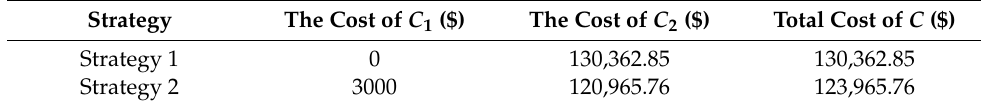
Table 1. Cost analysis under different preventive